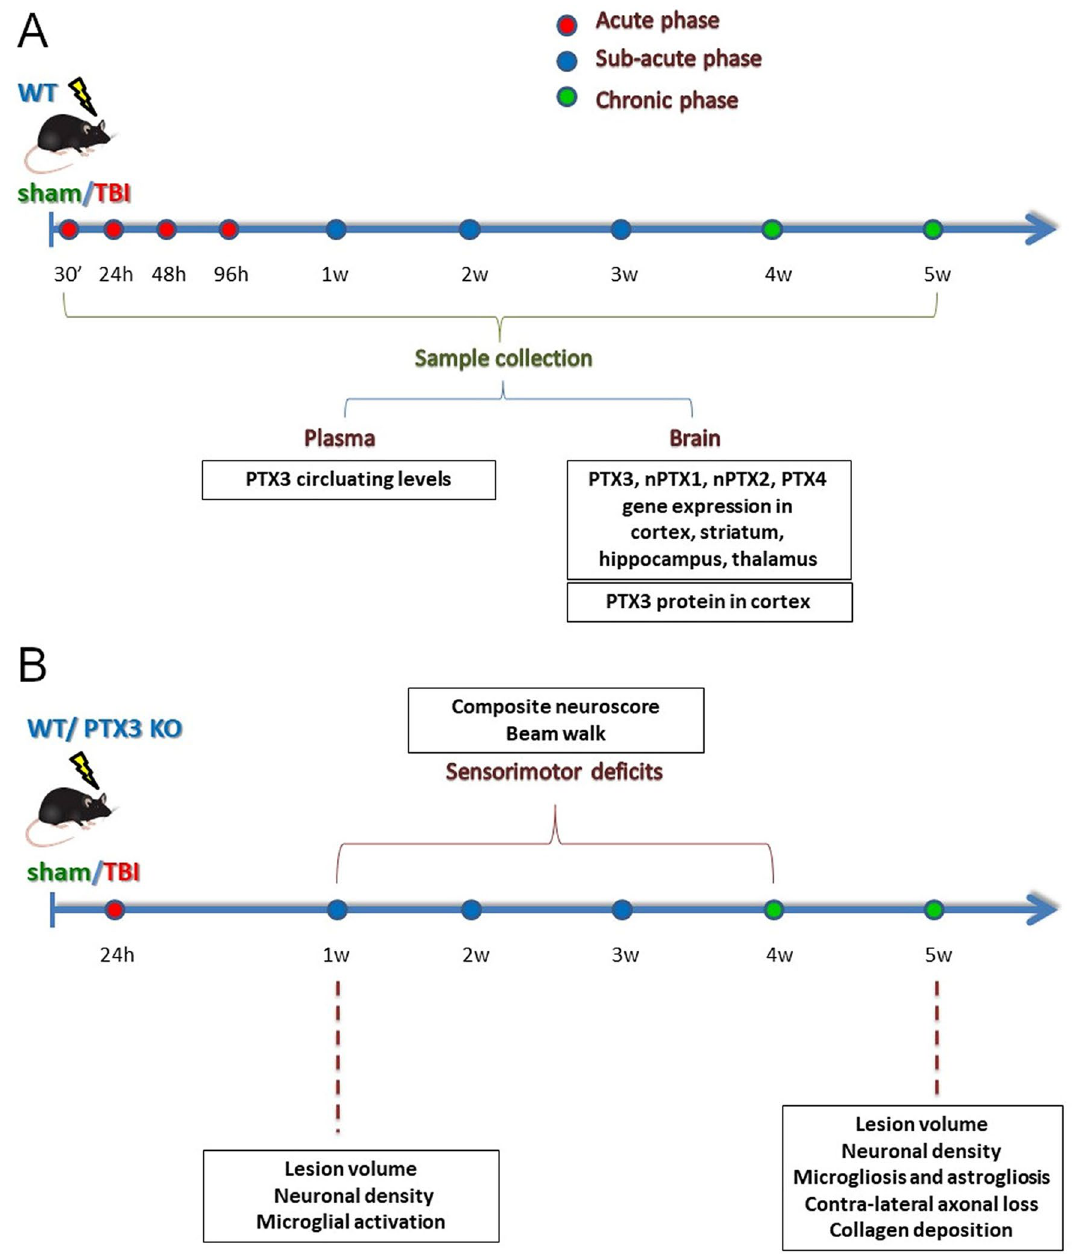
Figure 1. Experimental Plan. ( A ) WT mice underwent TBI or sham operation. TBI mice were sacrificed at different time points after surgery and plasma, whole brain or brain areas including cortex, striatum, thalamus and hippocampus were collected. PTX3 plasmatic levels were measured by ELISAs (naive; sham: 24 h, 5w; TBI: 30 ′ , 24 h, 48 h, 96 h, 1w, 2w, 3w, 5w). PTX3 presence (sham: 5w; TBI: 30 ′ , 24 h, 48 h, 96 h, 1w, 2w, 3w, 4w, 5w) and co-localization with neutrophils (Elastase; 48 h), neurons (NeuN; 1w), astrocytes (GFAP; 1w), microglia (CD11b; 1w), endothelial cells (CD31; 1w) and fibrin(ogen) (1w,2w) was studied by immunofluorescence assay on perfused brains. nPTX1, nPTX2, PTX3, PTX4 gene expression analysis was done on snap frozen brain areas by RT-qPCR (sham: 24 h, 96 h, 1w, 2w, 5w; TBI: 24 h, 96 h, 1w, 2w, 5w). ( B ) WT or PTX3 KO underwent CCI or sham operation. Sensorimotor deficits were assessed by composite neuroscore and beam walk tests on a weekly basis for four weeks after TBI. Brains from both strains were harvested for histopathological analysis: lesion volume and neuronal density with cresyl violet staining (1w; 5w); collagen presence with sirius red staining (5w); contra-lateral white matter loss with luxol fast blue staining (5w); astrogliosis (GFAP; 5w), microgliosis (CD11b/CD68; 5w) and shape descriptors microglia (CD11b; 1w) with